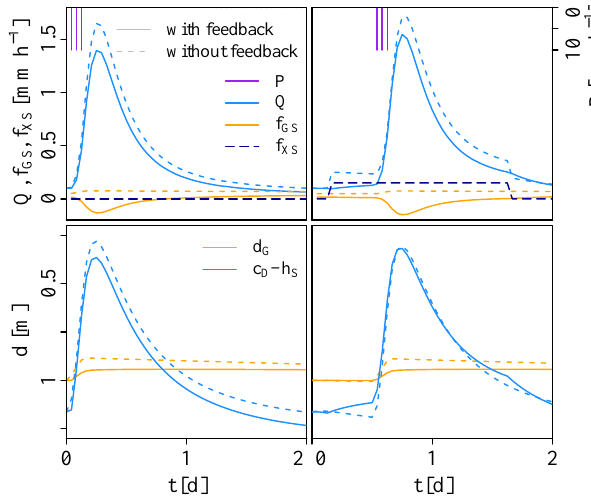
Figure 9. The isolated effect of taking into account the groundwater–surface water feedback process. Results of a numer- ical experiment with (solid) and without (dashed) using the surface water level ( h S ) in the groundwater drainage flux ( f GS ) computa- tion. Right panels also include the effect of surface water supply ( f XS ). For the dashed lines in the left panels, h S was computed without f XS and f XS was added to the discharge ( Q ) afterwards. The same parameter values as in Fig. 5 were